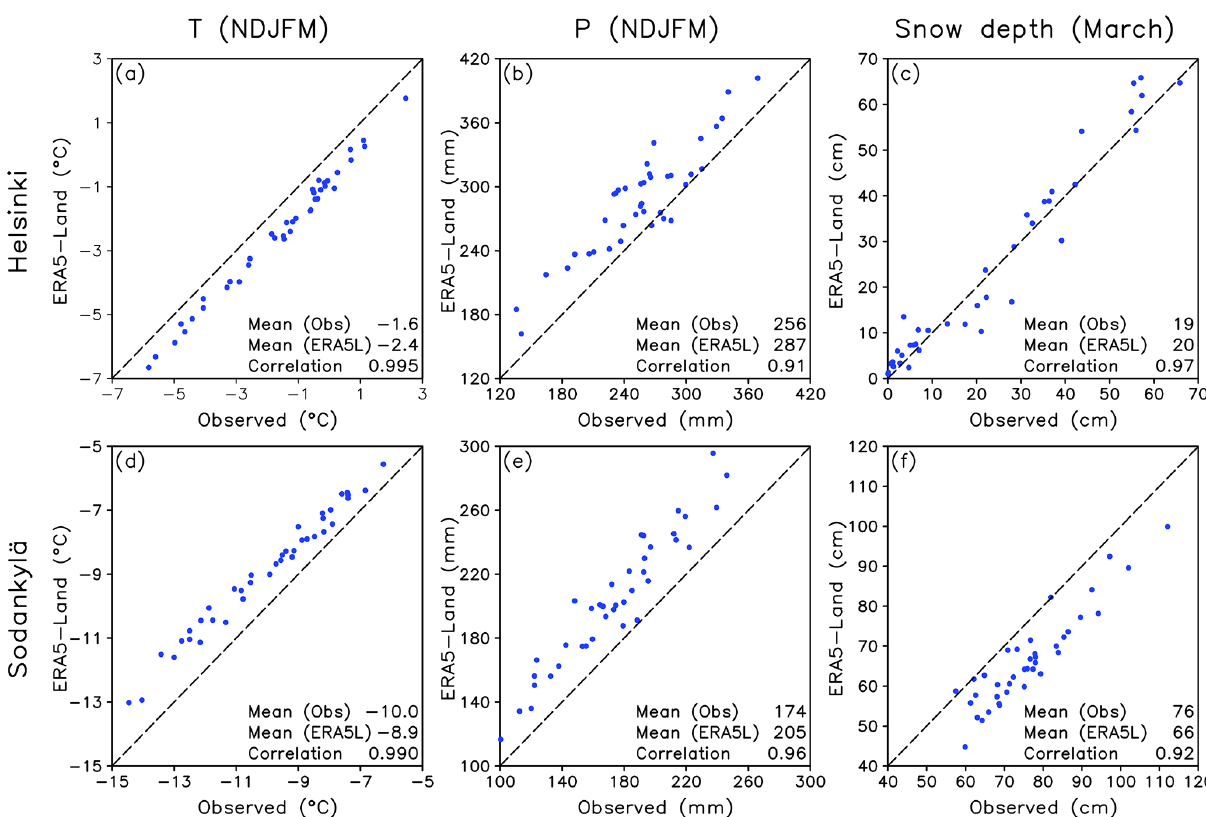
Figure 3. Comparison between station observations and ERA5-Land reanalysis of (a, d) NDJFM mean temperature, (b, e) NDJFM pre- cipitation and (c, f) March mean snow depth in winters 1981/82–2019/20. (a–c) Station Helsinki Kaisaniemi versus ERA5-Land (60.2 ◦ N, 25.0 ◦ E). (d–f) Station Sodankylä Tähtelä versus ERA5-Land (67.4 ◦ N, 26.6 ◦ E). Station observations from The Finnish Meteorological Institute (2021). ERA5L: